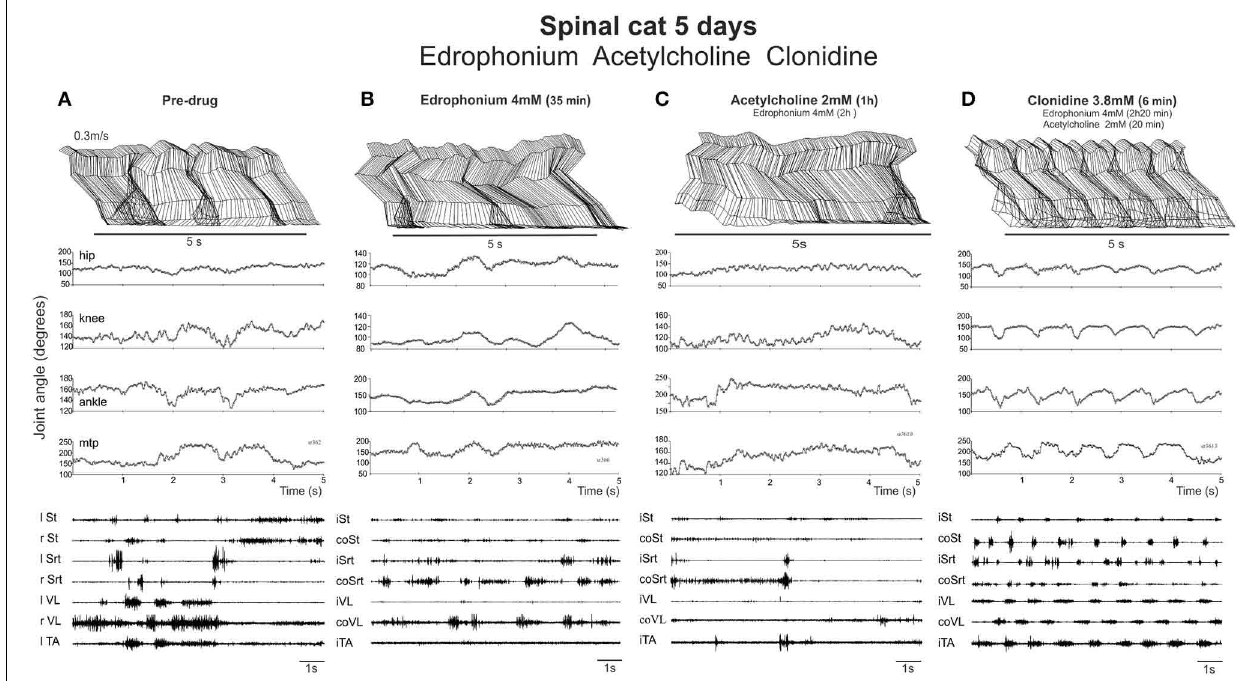
FIGURE 6 | Neither EDRO nor ACh in the presence of EDRO facilitated the onset of locomotor activity in a spinal cat. (A) Pre-drug records of a cat walking on a treadmill with strong exteroceptive stimulation used to activate the locomotor CPG. Stick figures of the limb trajectory over 5s of activity, along with the corresponding joint angles and EMG recordings are illustrated.